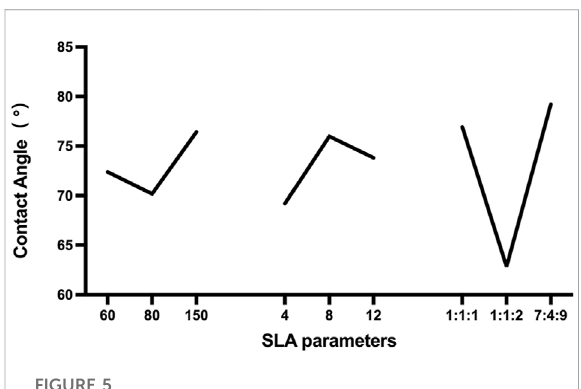
FIGURE 5 Trend in fl uence of SLA parameters on the contact